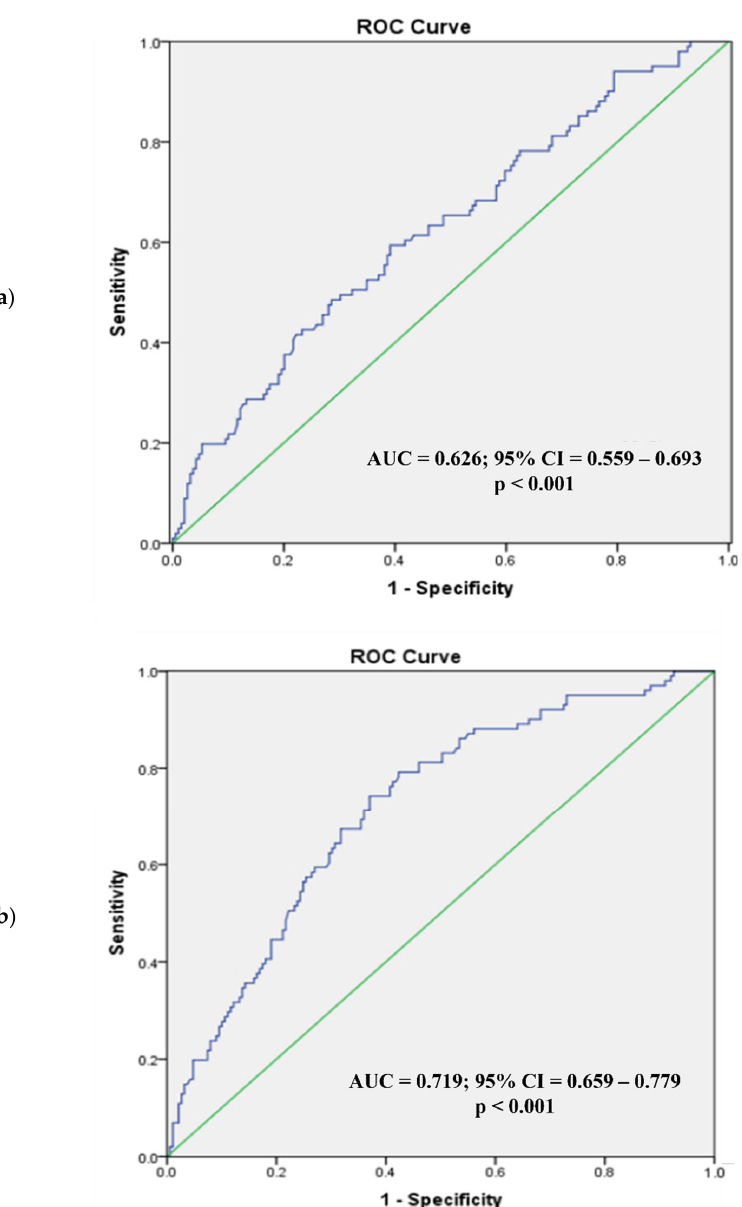
Figure 2. Receiver operating characteristic analysis of men with normal BMI (body surface area ( a ), body mass index ( b )). In normal-weight men, the AUC for BSA ( a ) was 0.626 (95% CI = 0.559–0.693; p < 0.001) and for BMI ( b ) 0.719 (95% CI = 0.659–0.779; p < 0.001). ROC, receiver operating characteristic; AUC, area under the curve; CI, confidence interval.